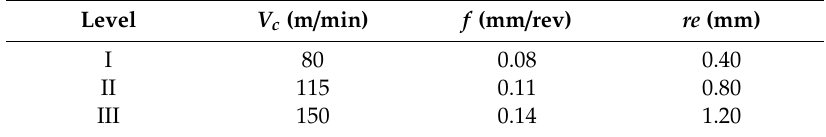
Figure 3. ( a ) The physical model of the CNGA120408T01020 ceramic and ( b ) the analogous CAD model with detailed geometry.